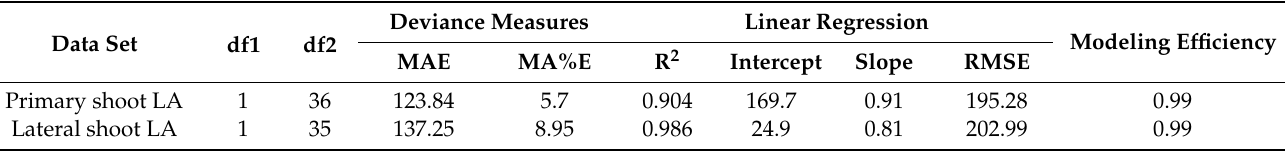
Table 1. Validation of the linear regression models for the primary and lateral shoot LA (ln (total LA] = α + ß × ln (average LA × NL)) estimation.